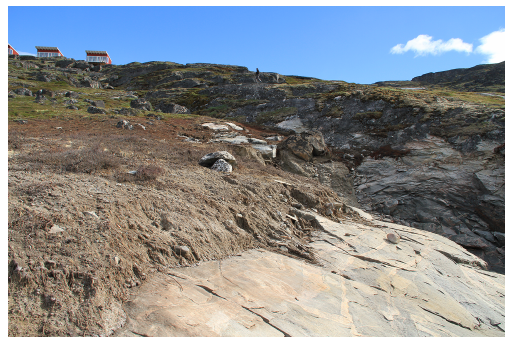
Figure 7. The tsunami waves lead to recent erosion of old vegeta- tion on the